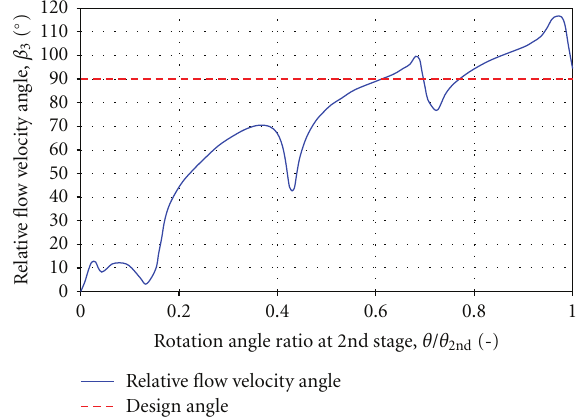
Figure 20: Absolute flow angles α 1 obtained for the numerical domains I and II along the normalized rotation sector at design